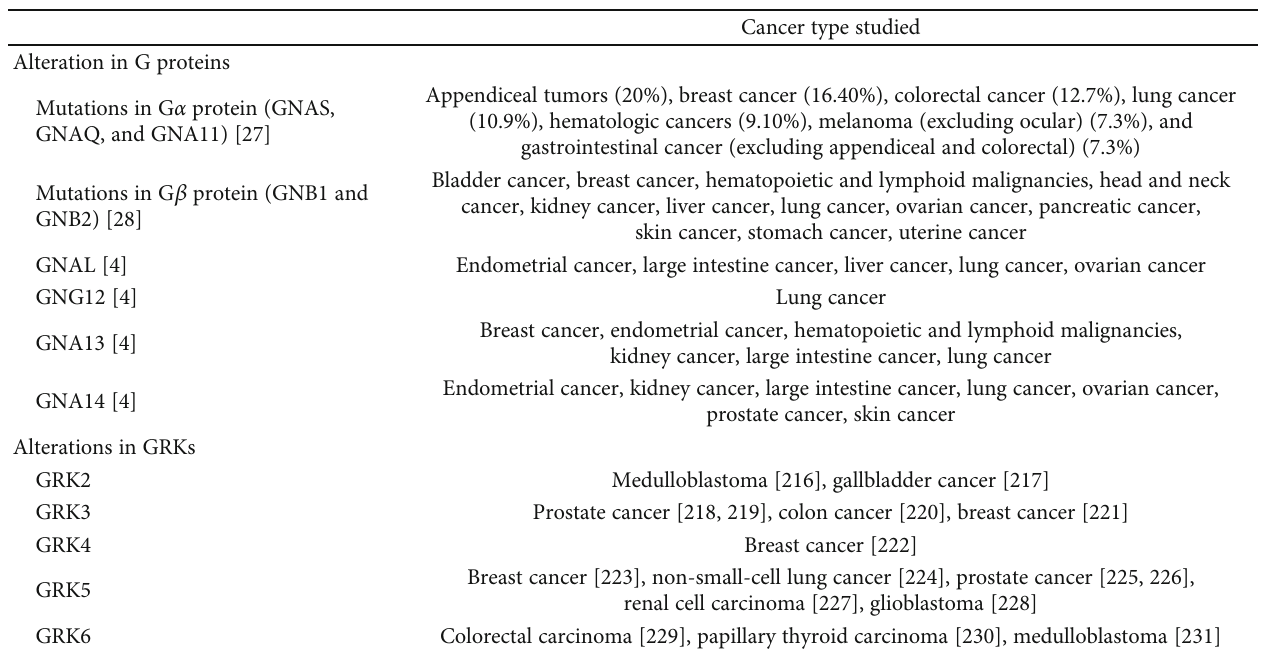
Table 3: Alterations in G protein and GRKs in